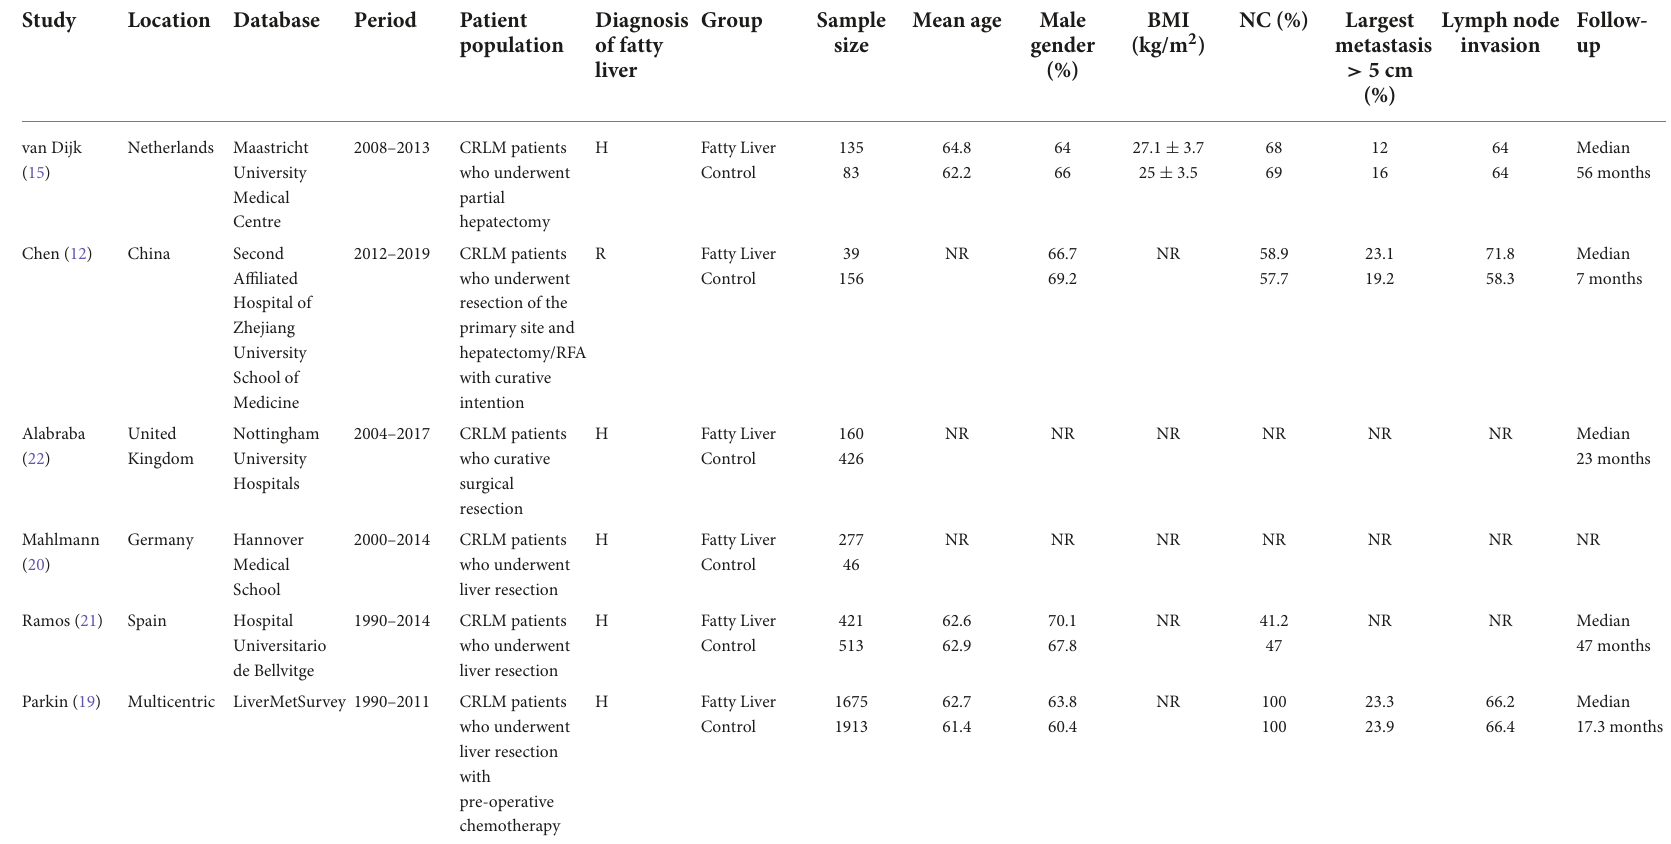
TABLE 1 Details of included